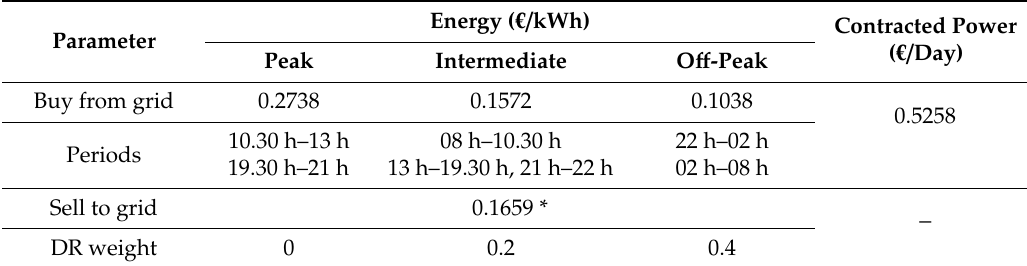
Table 1. Prices of the di ff erent periods and contracted